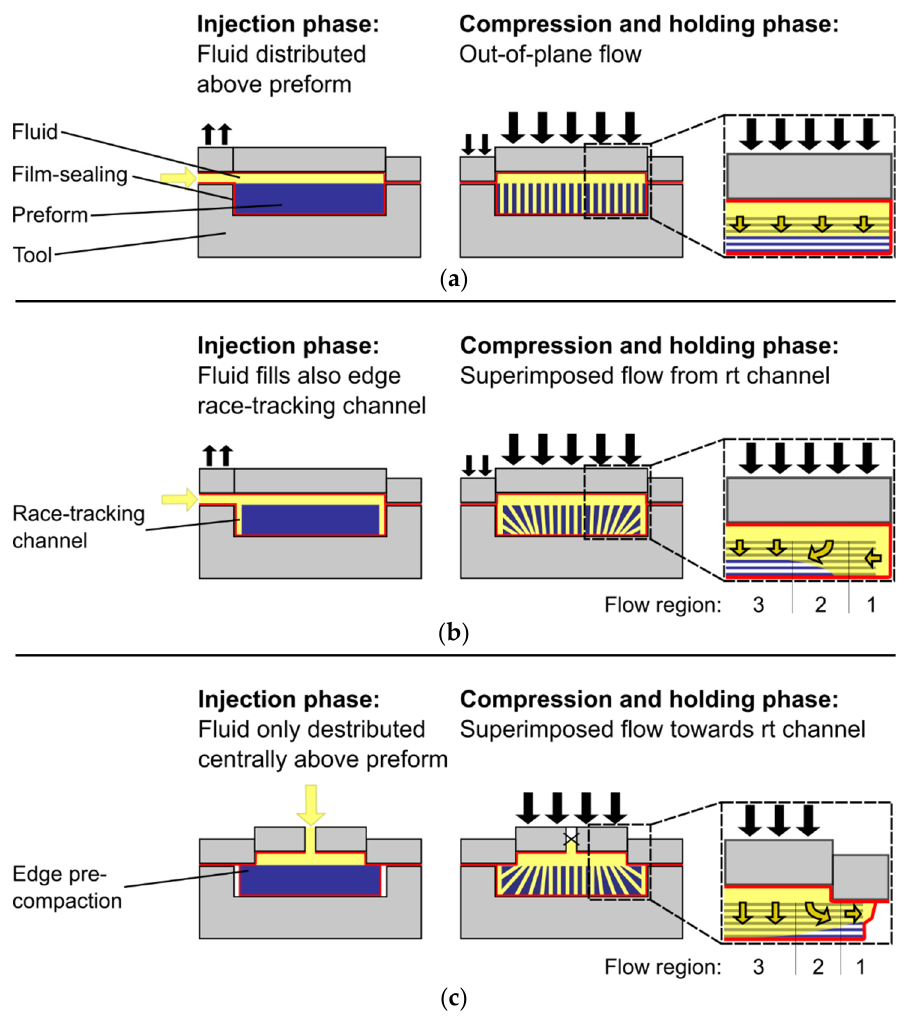
Figure 14. Flow scenarios derived from FS-CRTM experiments: ( a ) without edge race-tracking (rt) channel; ( b ) with edge race-tracking channel; and ( c ) with applied passive flow control strategy of a localized, central injection gap and pre-compaction of the preform edge.